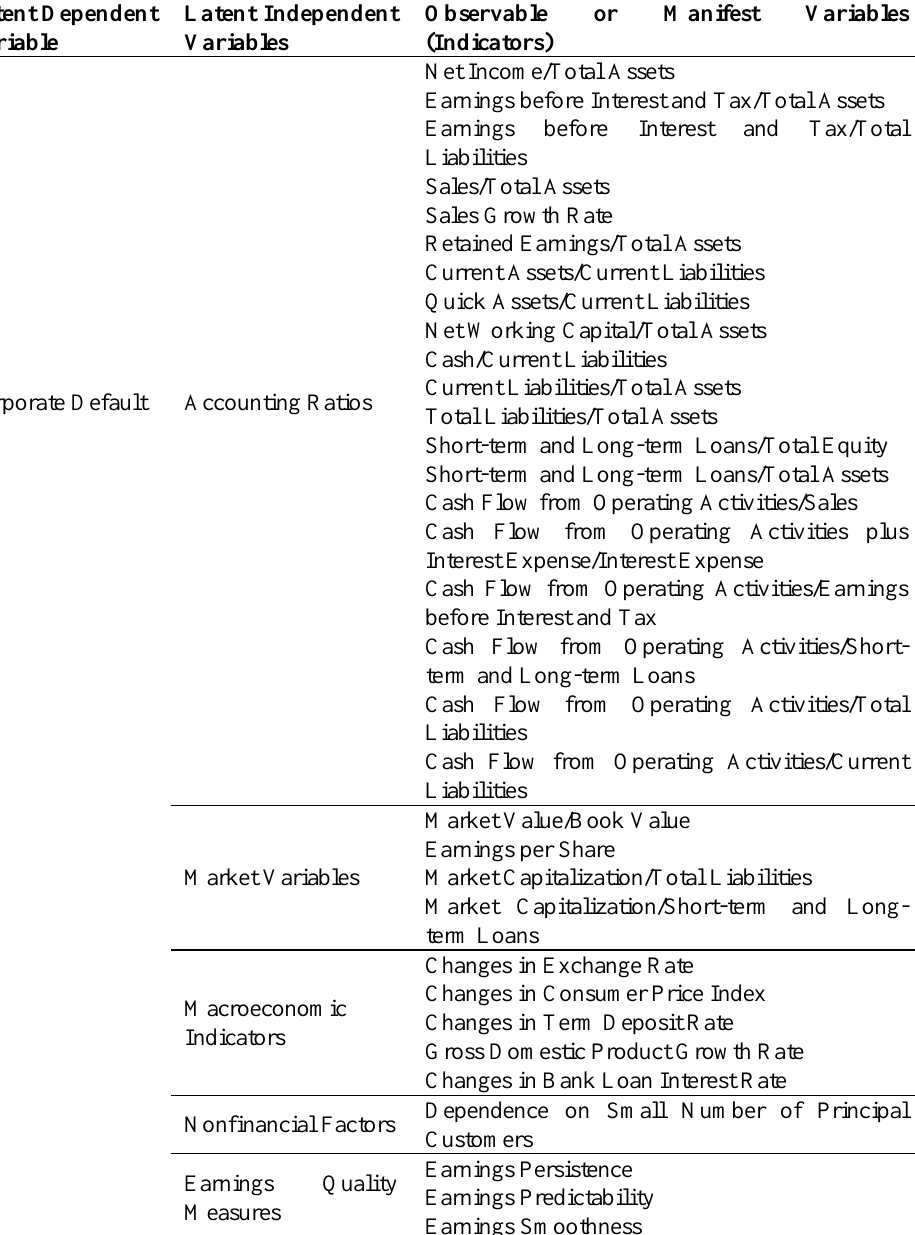
Table (4). Factors Affecting the Prediction of Corporate Default in Iran Latent